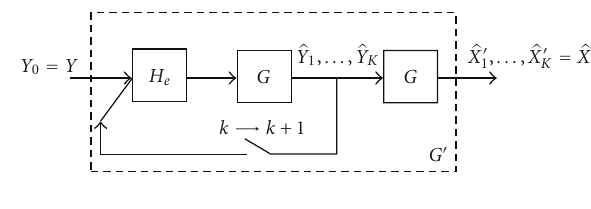
Figure 1: Proposed restoration